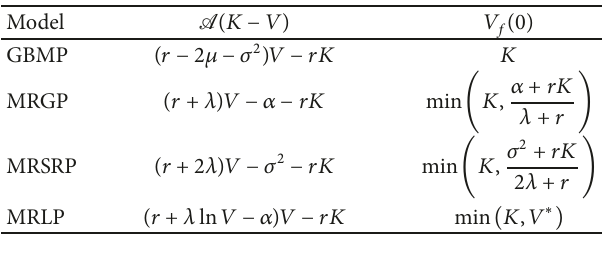
Table 2: The values of A (𝐾 − 𝑉) and 𝑉 𝑓 (0)